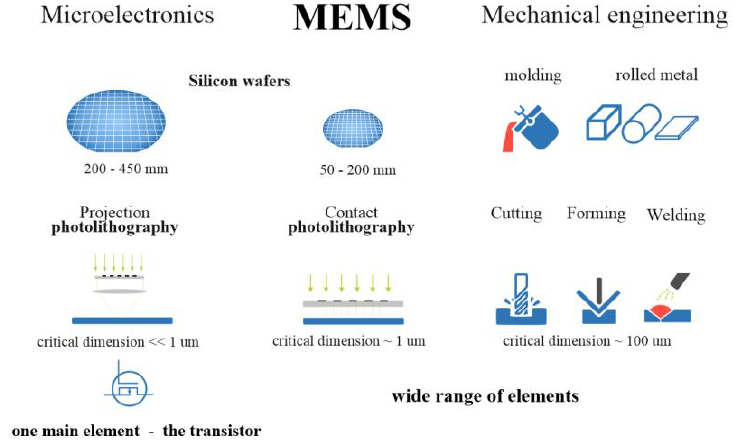
Fig. 4. MEMS at the intersection of two fields of